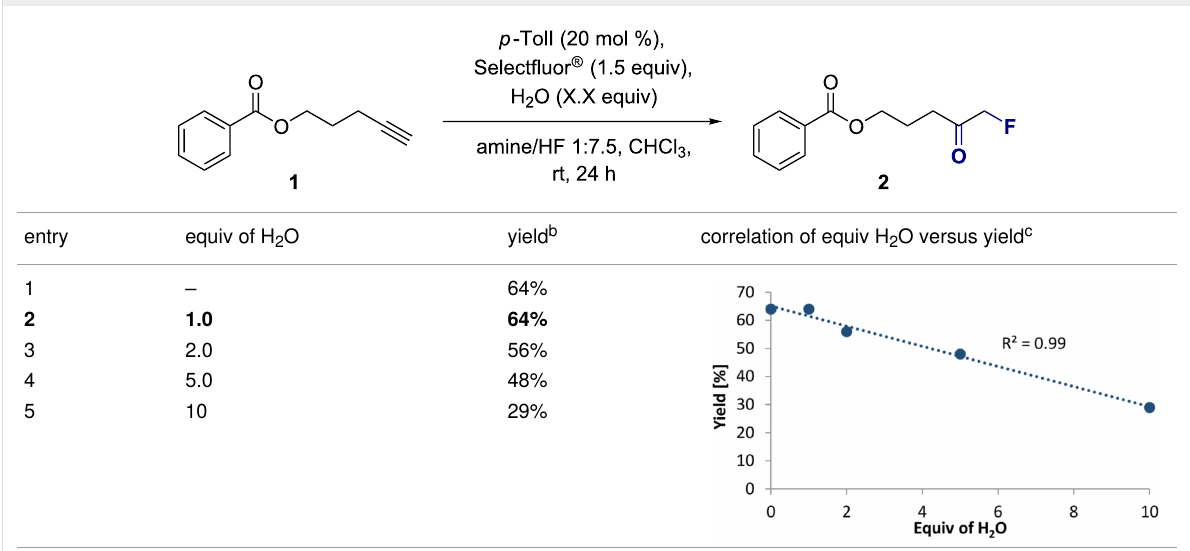
Table 2: Investigating the role of H 2 O during the reaction . a